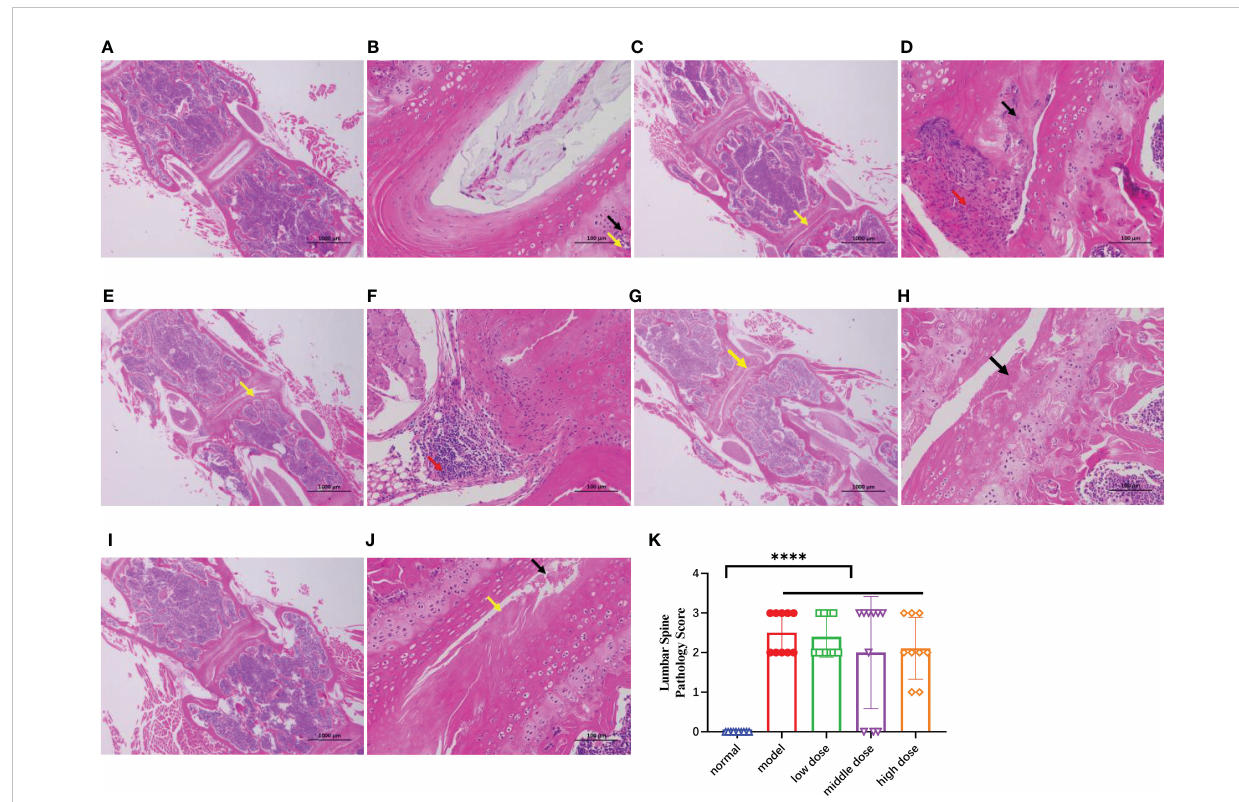
FIGURE 9 The HE staining results of the mouse spines in each group after paraf fi n embedding and longitudinal section at the 20th week, (A, B) : 20x and 200x photographed results of normal group, (C, D) : 20x and 200x photographing results of the model group, necrolysis of chondrocytes (black arrows) can be seen in multiple annulus fi brosus of the intervertebral disc, and cracks are formed (yellow arrows), with hyperplasia of connective tissue (red arrows) around; (E, F) : 20x and 200x photographing results of low-dose group, chondrocyte necrolysis (black arrows) can be seen in the annulus fi brosus of the intervertebral disc, and obvious Cleft formation (yellow arrows); focal in fi ltration of lymphocytes (red arrows) can be seen locally; (G, H) : 20x and 200x photographic results in the middle-dose group, necrolysis of chondrocytes in the annulus fi brosus of the intervertebral disc (black arrows), and obvious fi ssure formation (yellow arrow) can be seen. (I, J) : 20x and 200x photographing results in high-dose group, necrolysis of chondrocytes (black arrows) and obvious cleft formation (yellow arrows) can be seen in multiple annulus fi brosus of intervertebral discs; (K) : Mouse lumbar spines lesion score, Data are presented as mean ± SD. ****p ≤ 0.0001 vs. Normal. In model group, low dose group, middle dose group, n=10; in high dose group, n=9.